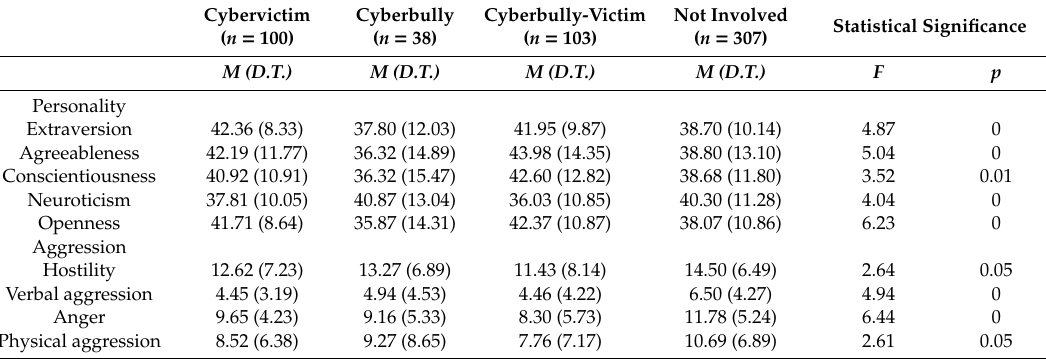
Table 1. Di ff erences in means and standard deviations for personality traits and aggression between students who are pure victims and bullies, victimized bullies and not involved in cyberbullying.